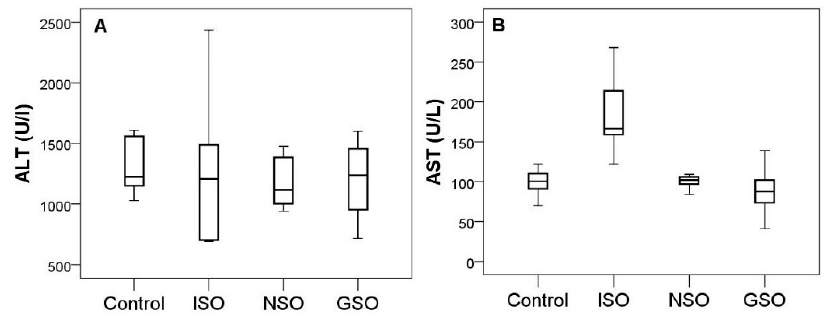
Figure 5. ALT ( A ) and AST ( B ) serum levels in the experimental groups.